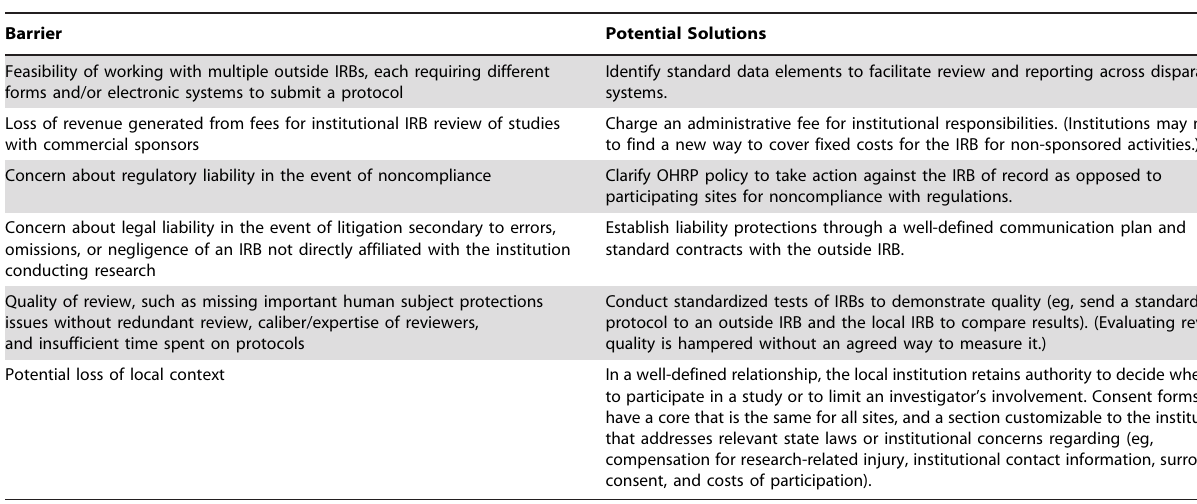
Table 1. Perceived Barriers to Using Centralized IRB Review in Multicenter Clinical Trials in the United States and Proposed